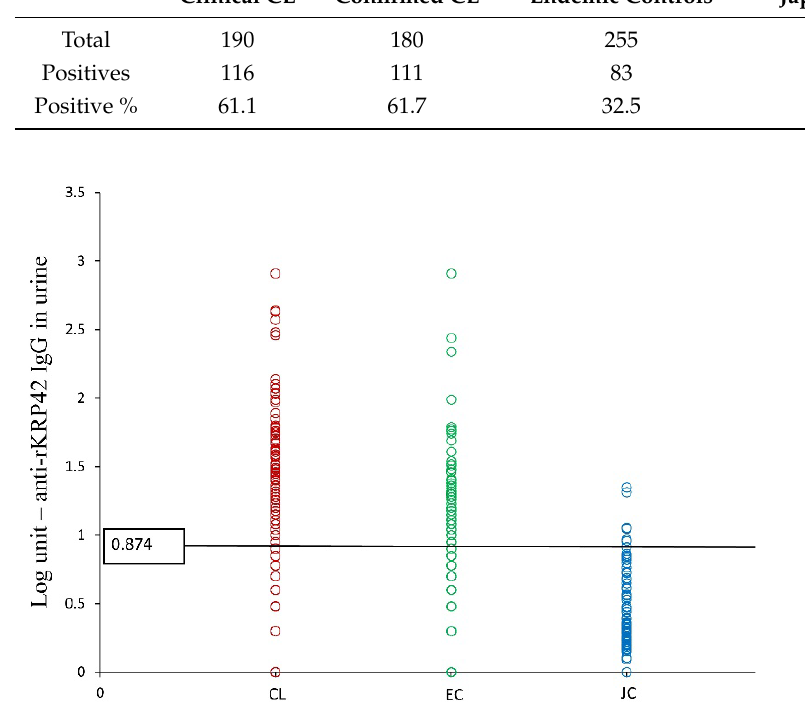
Table 3. Anti-rKRP42 IgG titers in urine.